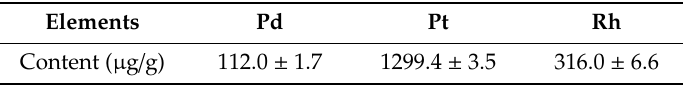
Table 1. Chemical composition of PGE in used catalytic